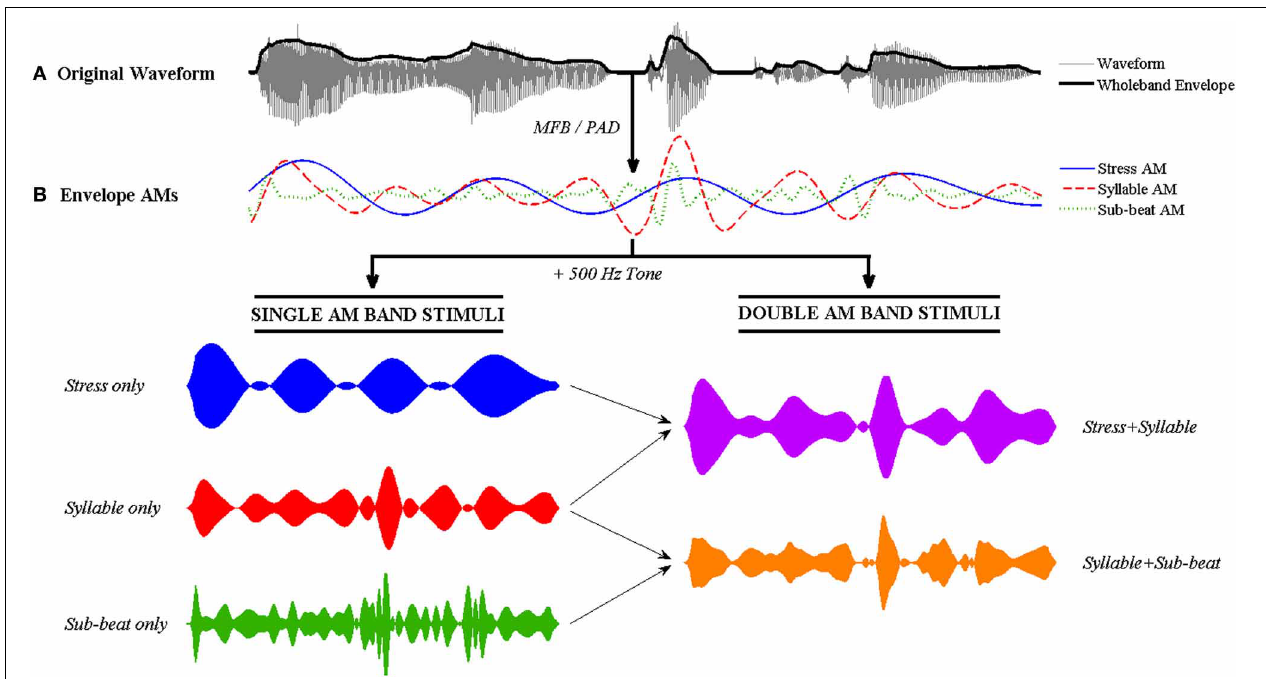
FIGURE 2 | Illustration of the signal processing steps involved in tone-vocoding for the nursery rhyme sentence “Mary Mary quite contrary.” (A) The original speech signal with its wholeband amplitude envelope overlaid in bold. (B) The Stress AM, Syllable AM and Sub-beat AMs are extracted from the envelope using either the MFB or PAD method. Single and double AM band vocoded stimuli are then generated by combining the